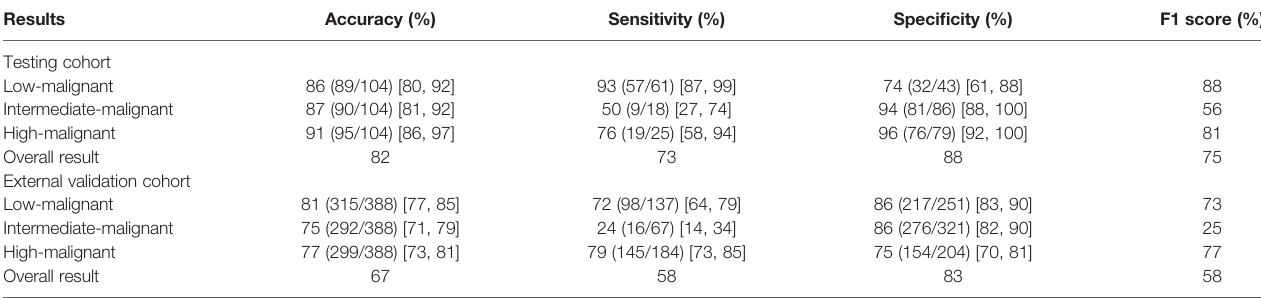
TABLE 2 | Predictive performance of DLM in the testing and external validation